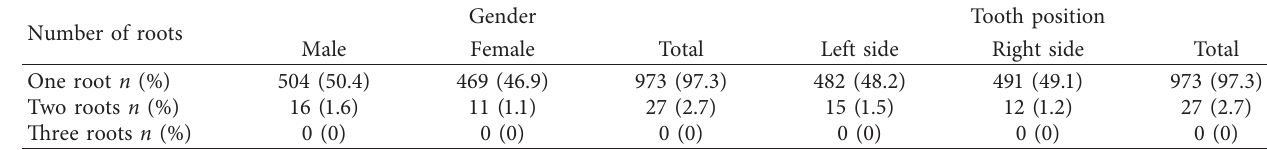
Table 1: Number of roots for gender and tooth position in the studied sample.